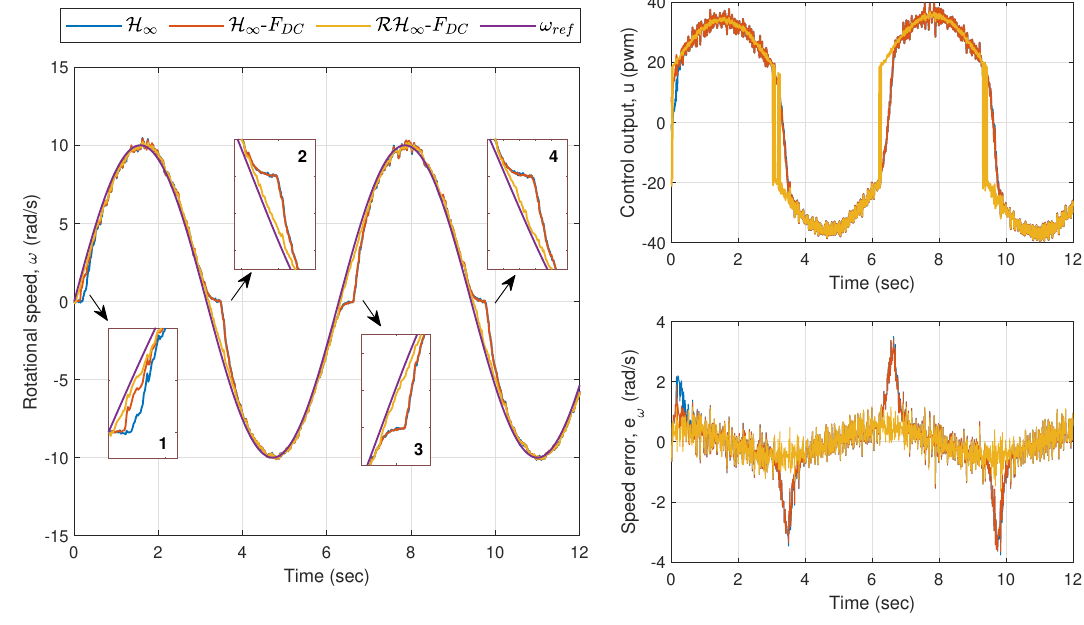
Figure 11. Exp. 1.3: Time responses of Motor A for a sinusoidal wave input. Speed errors are relatively larger via H ∞ and H ∞ - F DC as compared to the error via RH ∞ - F DC